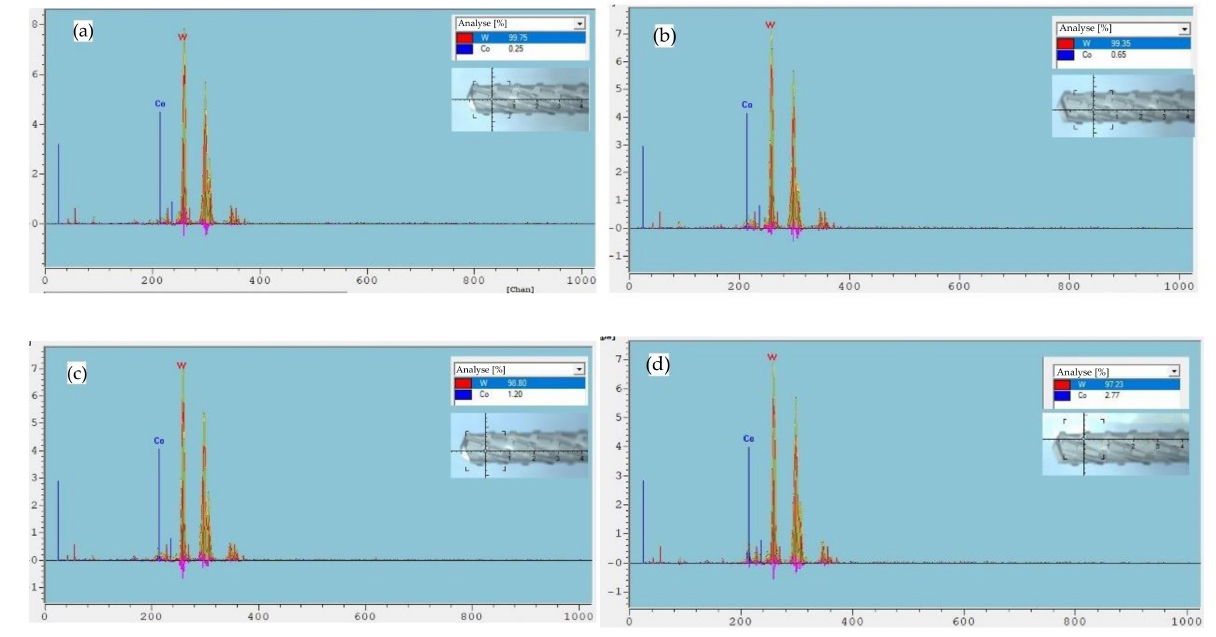
Figure 3. XRF spectra of the substrate surface of milling cutters with different pretreatment schemes. ( d ) Scheme D (Acid etching 10 s).